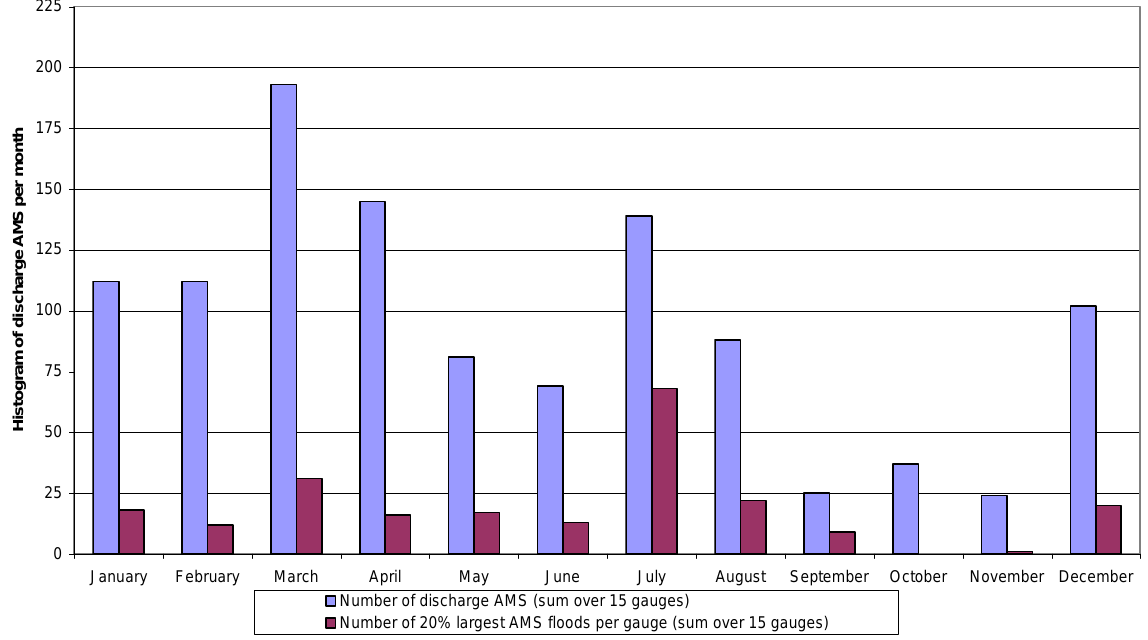
Fig. 4. Monthly distribution of the number of discharge AMS, summed up over the 15 gauges for all AMS floods and for the 20% largest events